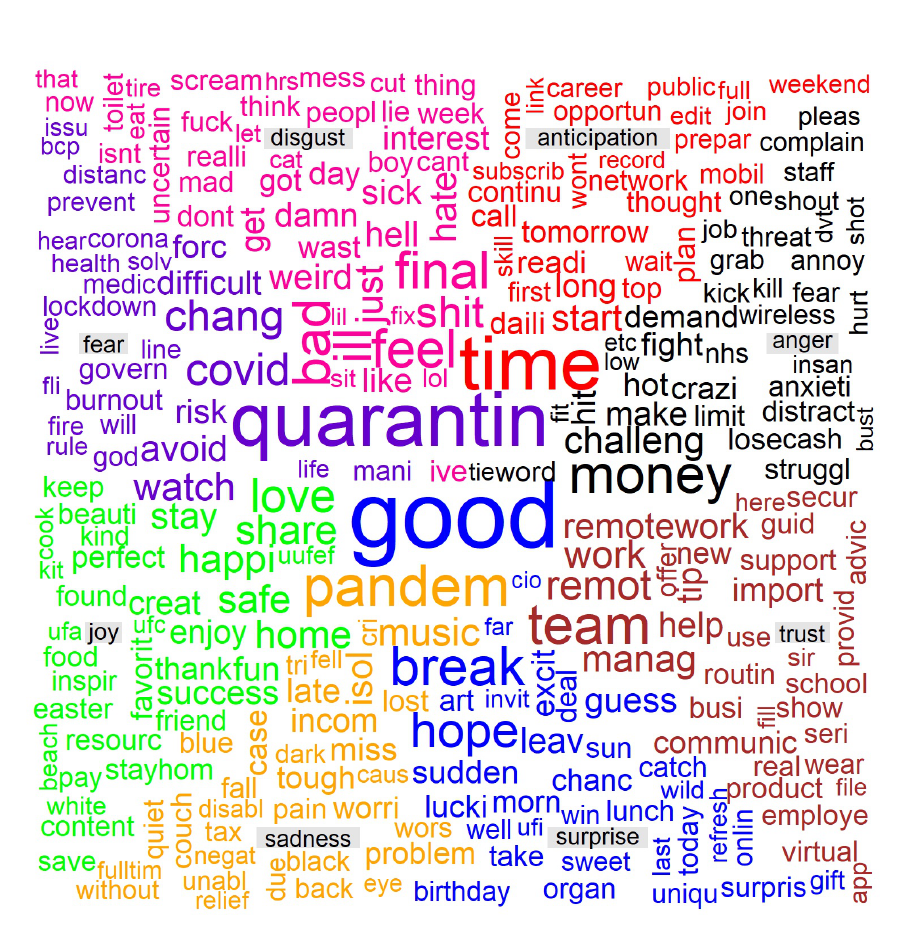
Fig. 2. Word Cloud of the Tweets related to Work from